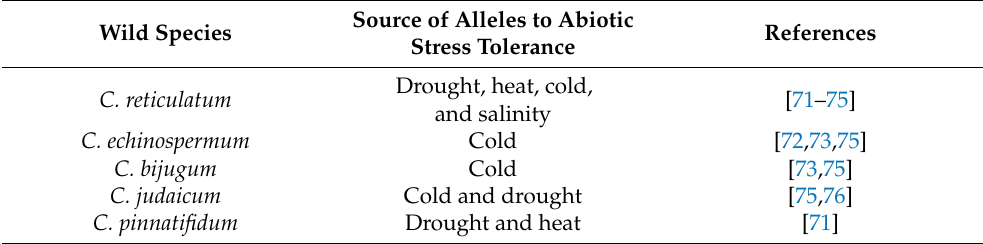
Table 1. Wild Cicer species as sources of alleles to abiotic stress tolerance in chickpea. Wild